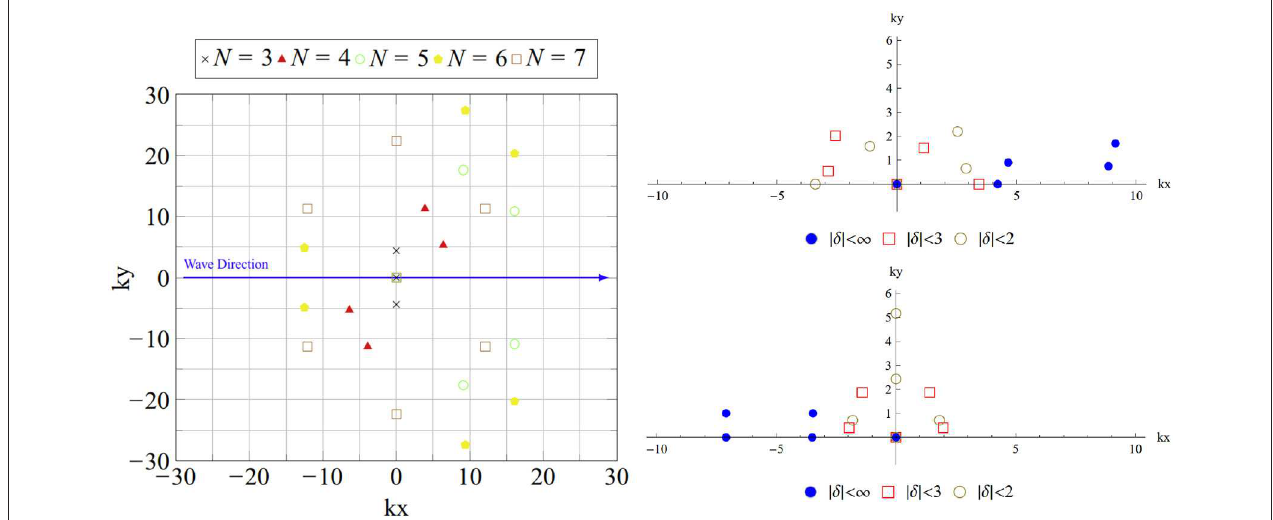
FIGURE 5 | (Left) Optimal layout for arrays of 3–7 WECs, obtained through sequential quadratic programming where the starting point for the layout has been chosen based on a heuristic optimization algorithm (Moarefdoost et al., 2017). (Right) Optimal layouts for arrays with five WECs with constrained motion amplitude δ (McGuinness and Thomas, 2019). In the upper figure, the incident waves propagate in directions close to the y -axis, and in the lower figure, the incident waves propagate in a wider range of directions. All layouts have a WEC at the origin.